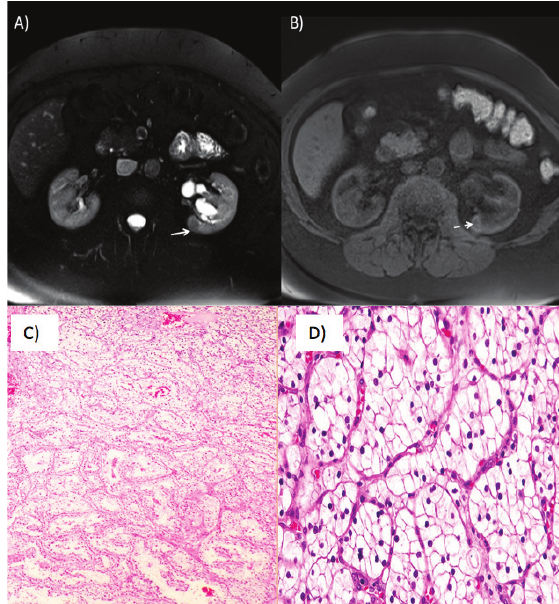
Figure 2. (A) Axial T2 weighted images show a T2 hypoin- tense lesion in the posteromedial aspect of the midportion of the right kidney (white arrow). (B) Axial T1 postcontrast images show enhancement of the lesion (dashed white arrow) indicating a solid renal mass such as renal cell